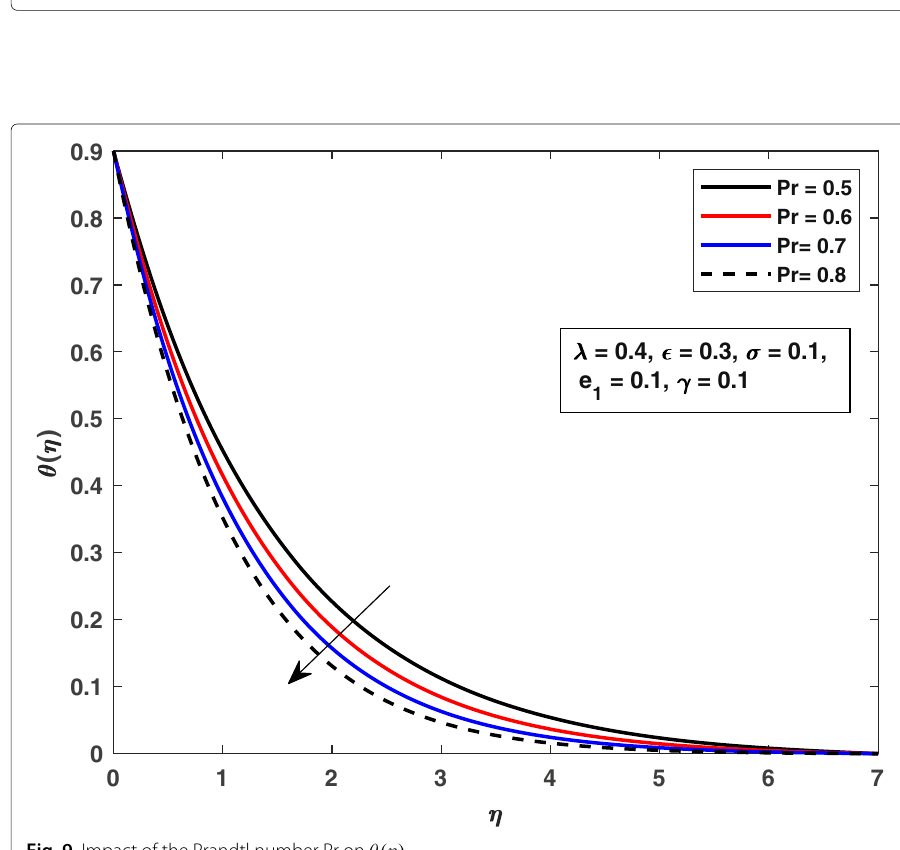
Fig. 8 Impact of the Prandtl number Pr on f (cid:6) (η)